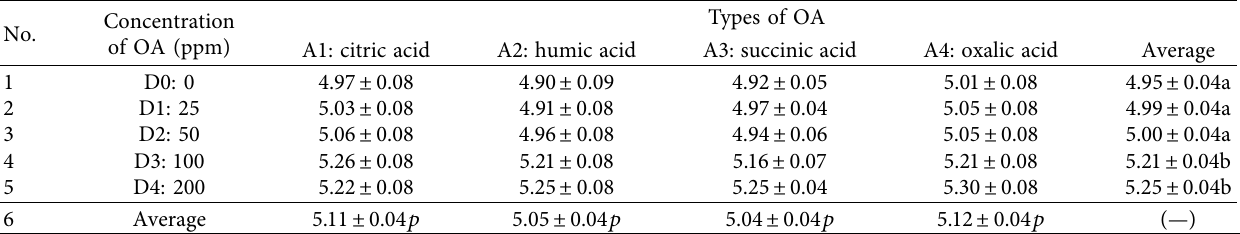
2 O average from 4 observation times.